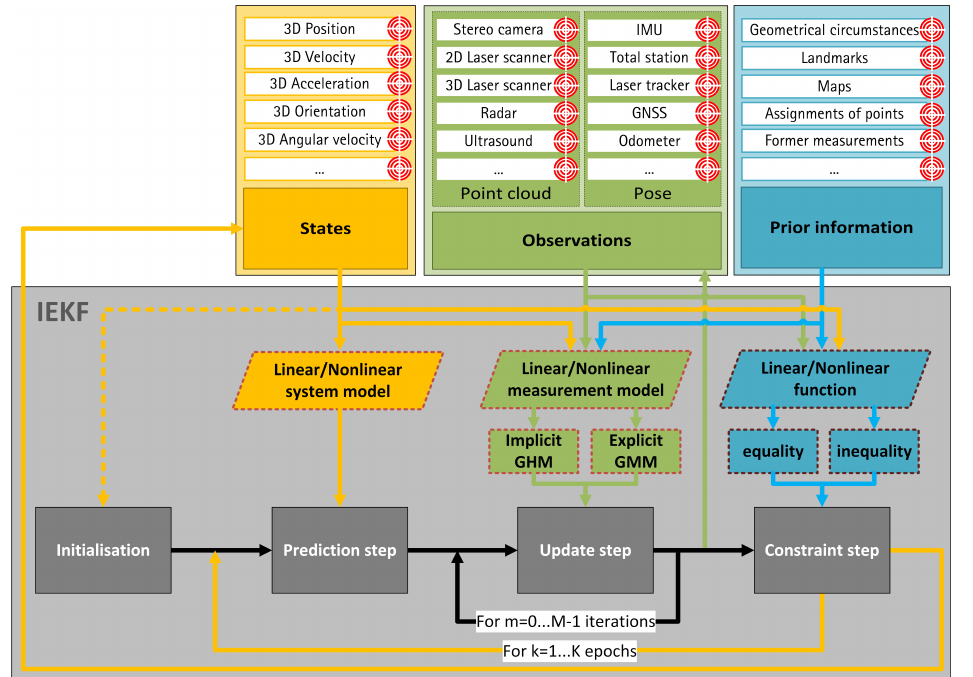
Figure 1. Schematic procedure of the universal recursive filter approach for georeferencing of a kinematic multi-sensor systems (MSS). Steps of the iterated extended Kalman filter (IEKF) (grey) are depicted with possible requested states (yellow), available observations (green) and known prior information (blue). Respective uncertainty information are depicted by red target